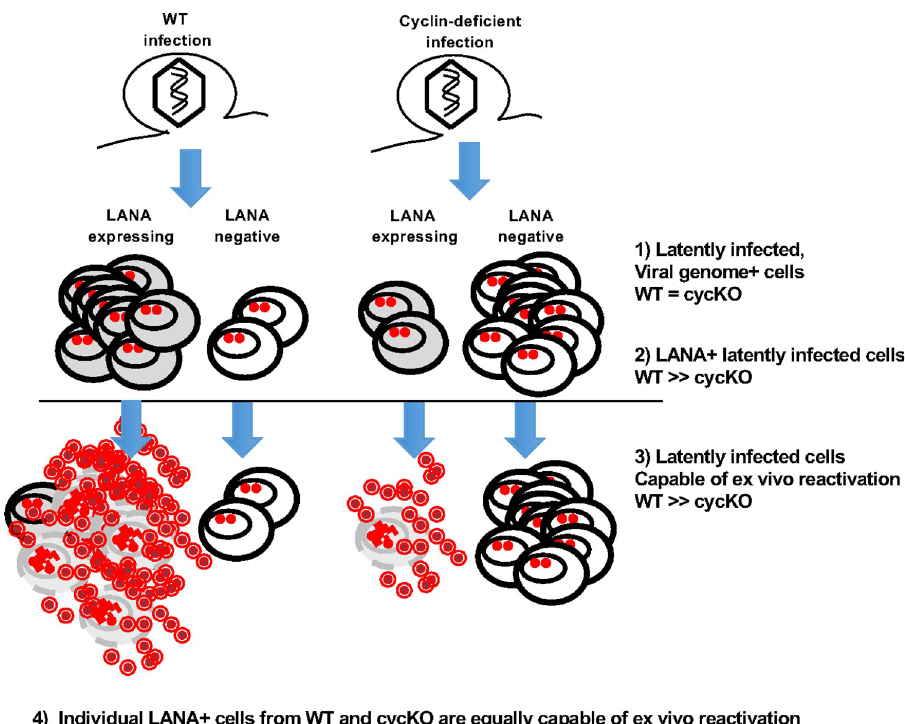
Fig 9. The viral cyclin drives reactivation through increasing the pool of LANA expressing, reactivation- competent, infected cells. Wild-type γ HV68 infection results in establishment of latency (depicted by nuclear viral episomes). At least two distinct populations of latently infected cells arise, cells expressing viral LANA (gray) and those lacking detectable LANA expression (white). The LANA expressing cells are permissive to reactivation and will readily reactivate when triggered. Latent cells lacking LANA are incapable of reactivation, and instead remain dormant in latency. Infection with a viral cyclin-deficient γ HV68 virus also results in establishment of latency, with equivalent numbers to wild-type infection. However, without the viral cyclin, latency is skewed to reactivation incompetent, LANA negative cells. The cyclin-deficient infected cells which do express LANA are still able to reactivate, as efficiently as wild-type, but there are diminished numbers of these cells ultimately leading to the reactivation